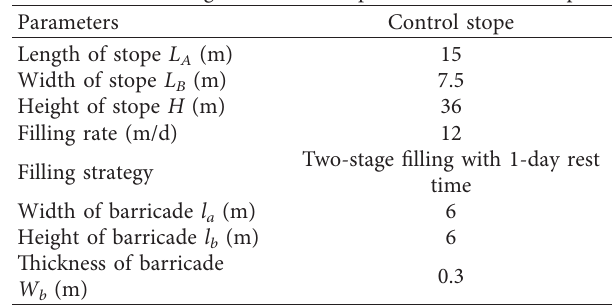
Table 8: Backfilling conditions adopted in the control stope.